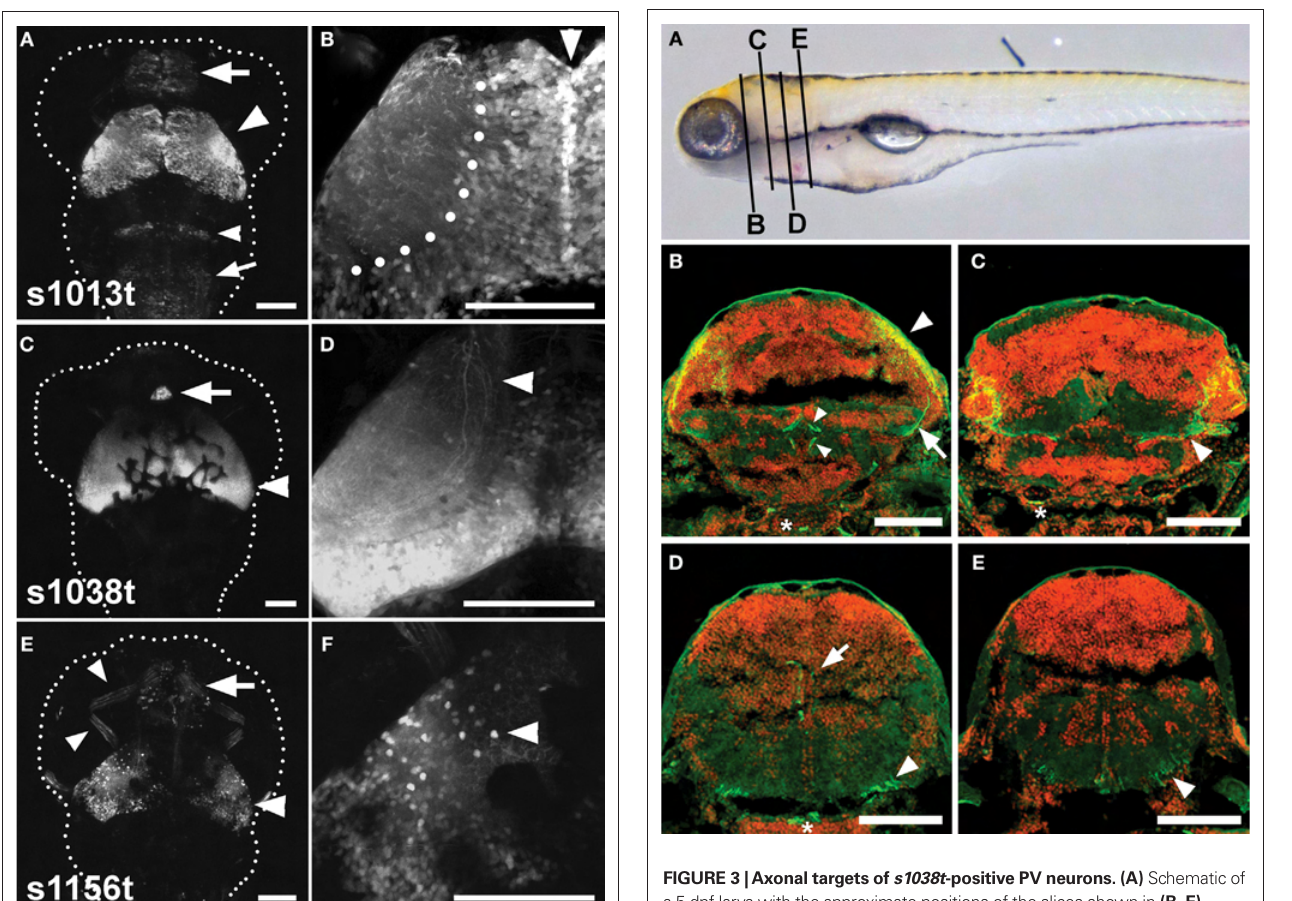
FiGUrE  | Axonal targets of s1038t -positive PV neurons. (A) Schematic of a 5-dpf larva with the approximate positions of the slices shown in (B – E) . Kaede fluorescence (green) shows s1038t PV neurons and cell bodies (DAPI, false colored red) provide landmarks throughout the brain. Axons of PV neurons [cell bodies indicated by arrowhead, (B) ] extend ventrally [arrow, (B) ] and out of the tectum. They can be seen to course medially [arrowhead, (C) ] before terminating in the superior Raphe nucleus [small arrowheads, (B) ]. Other axons from these neurons terminate in the superior reticular formation [arrow, (D) ] or extend caudally [arrowhead, (D) ], terminating in the medulla oblongata [arrowhead, (E) ]. Asterisks indicate non-neural staining. Scale bars indicate 100 μm. Larvae are 6-dpf, and are heterozygous for the s1038t Gal4 insertion and UAS:Kaede